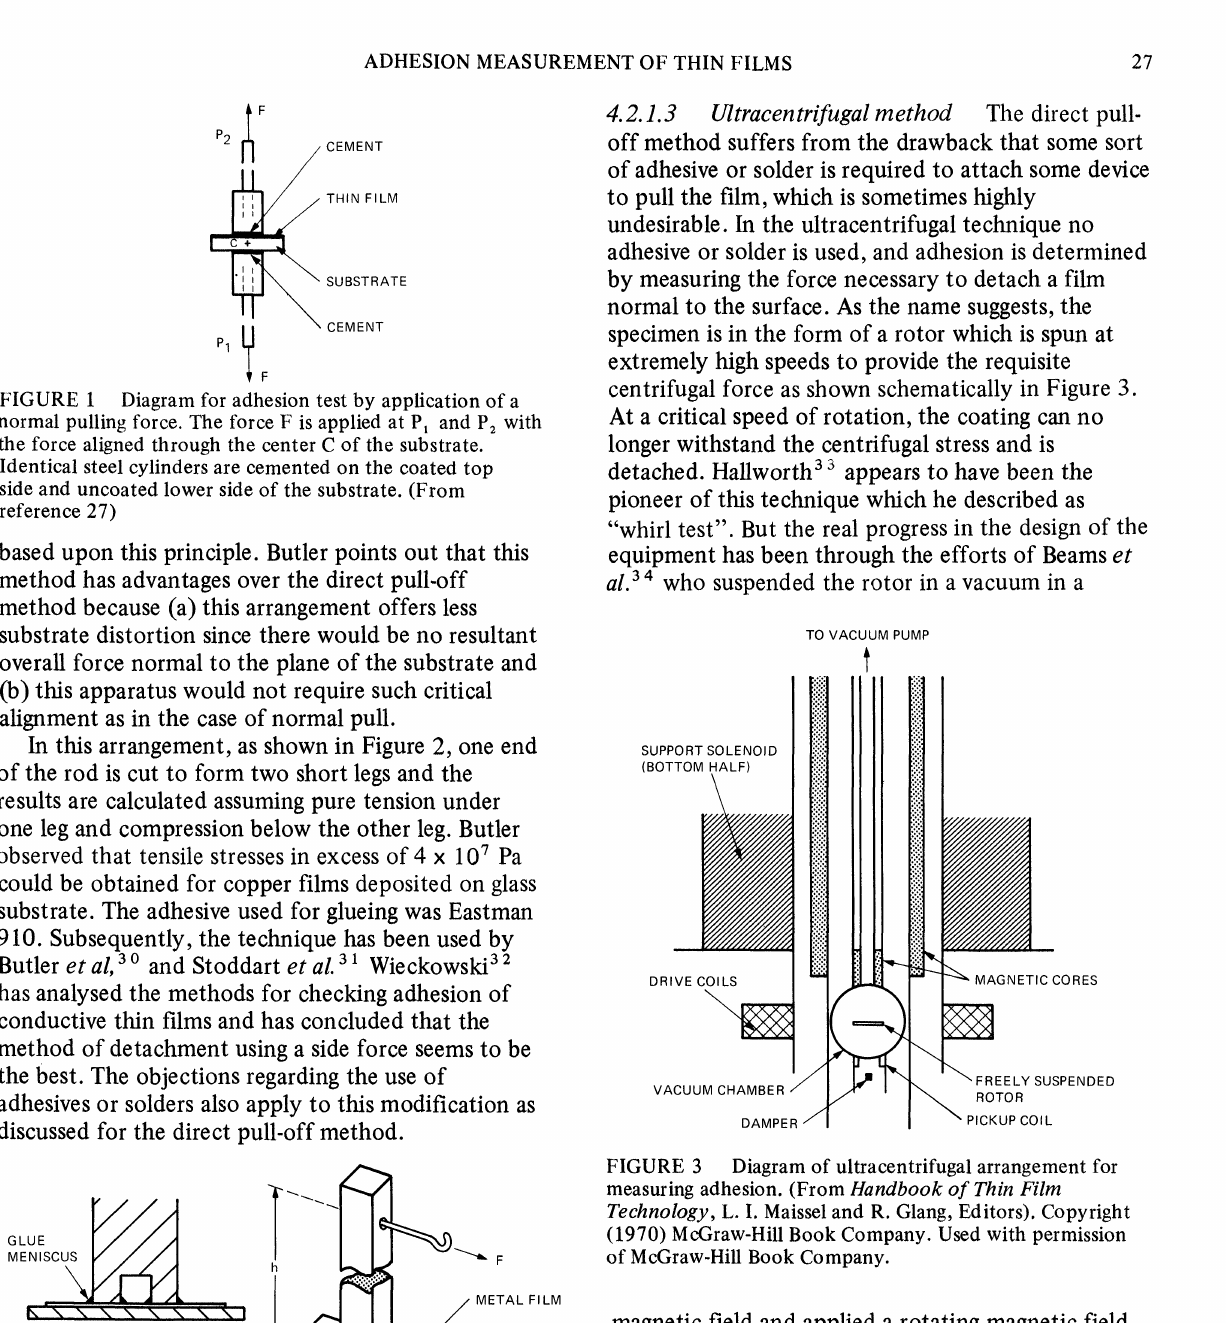
Diagram of ultracentrifugal arrangement for measuring adhesion. (From Handbook of Thin Film Technology, L. I. Maissel and R. Clang, Editors). Copyright (1970) McGraw-Hill Book Company. Used with permission of McGraw-Hill Book